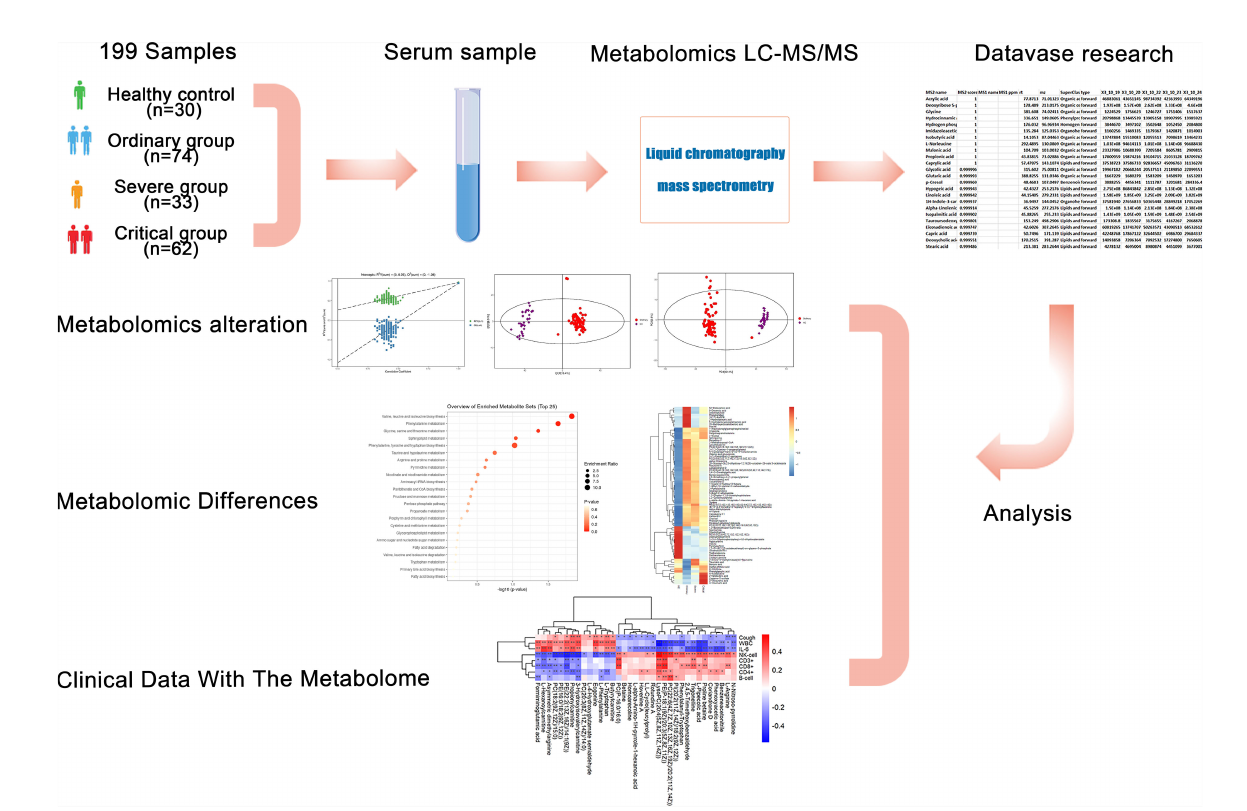
FIGURE 1 | Study design and metabolomics pro fi ling of COVID-19 sera. Overview of cohort (including 30 healthy control samples, 74 ordinary COVID-19 patients, 33 severe COVID-19 patients, and 62 critical COVID-19 patients), and the study design (including metabolomics LC-MS/MS, database search, clinical data, and